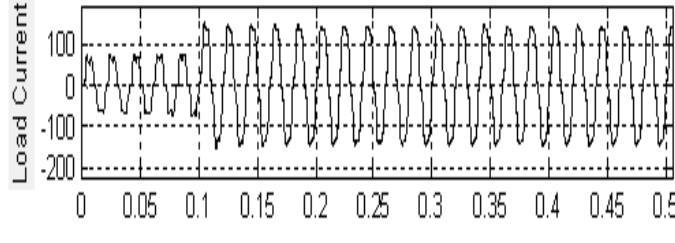
Figure 9a. “Load Current under dynamic behavior”.